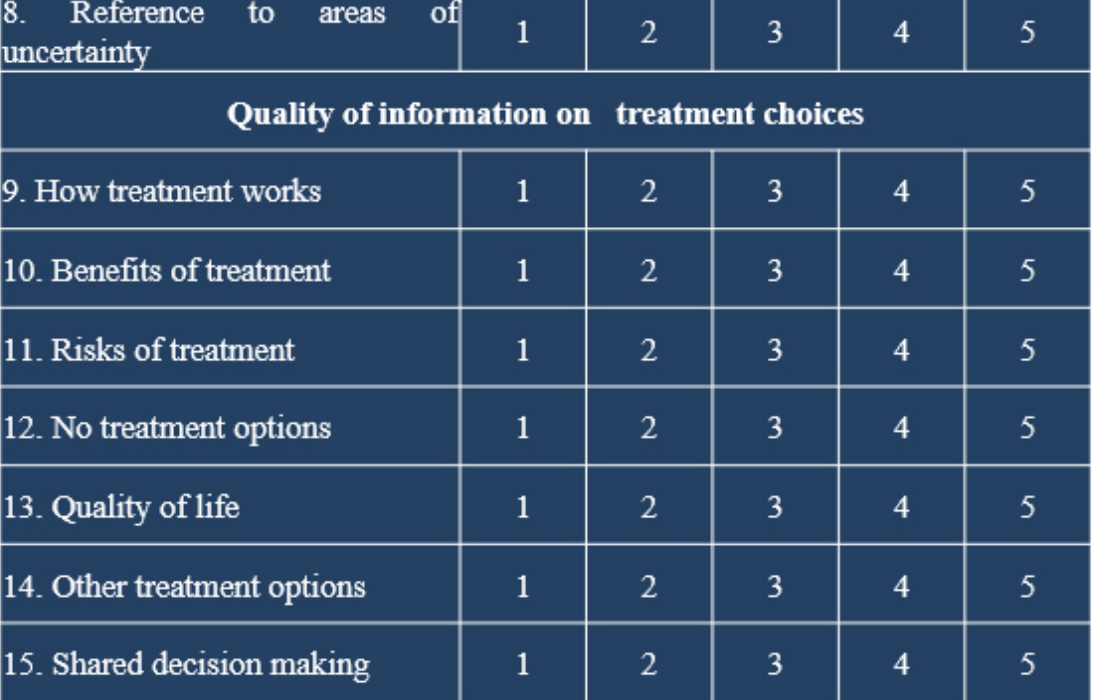
Fig. 1. Scoring of the DISCERN scale